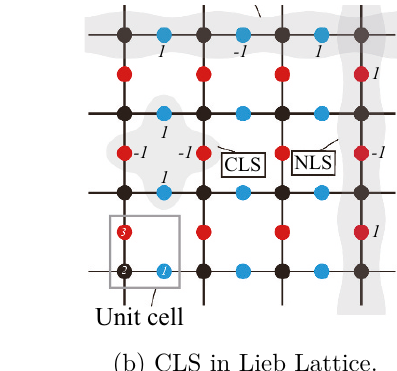
(b) CLS in Lieb Lattice. Figure 4 . Compact localized states (CLS) are formed if two neighboring sites in the orbit contribute hopping amplitudes such that they cancel each other so that an electron can not escape the orbital. This figures are from ref.